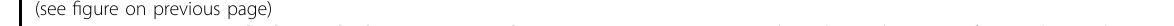
Fig. 1 p97 expression is higher in the breast CSC population. a Representative immunohistochemical staining of p97 in human breast, colon, liver, and pancreatic cancers and adjacent noncancerous tissues. Bar: 20 μ m. b Representative immunohistochemical staining of high-level p97 (red) co-stained with CD44 (brown, left) and CD24 (brown, right) in two consecutive serial sections of human breast cancer tissues. c Representative immunohistochemical staining of low-level p97 (red) co-stained with CD44 (brown, left) and CD24 (brown, right) in two consecutive serial sections of human breast cancer tissues. Bar: upper 200 μ m, lower 50 μ m. Note that p97 primarily localized to CD44 + /CD24 − cells but not other cells. d Percentages of p97 expression in CD44 + /CD24 − cells and non-CD44 + /CD24 − (CD44 − /CD24 − , CD44 − /CD24 + , and CD44 + /CD24 + ) cells in breast cancer tissues ( n = 75). e Immunohistochemical staining of SOX2 and p97 in the consecutive serial sections of breast cancer tissues. SOX2 and p97 expressions were classi fi ed as low and high. Bar: upper 200 μ m, lower 50 μ m. f Correlation analyses of SOX2 and p97 expression in breast cancer tissues ( n = 75). g Immunoblotting of p97 in lysates of MCF10A, MCF-7, and MDA-MB-231 cells. GAPDH was used as a loading control. h Left: fl ow cytometry analysis of CD44 and CD24 in MCF10A, MCF-7, and MDA-MB-231 cells. Right: the CD44 + /CD24 − percentages. i qPCR analysis of P97 mRNA in CD44 + /CD24 − , non-CD44 + /CD24 − , ALDH + , ALDH − , PKH26 + , and PKH26 − populations. j , k Immunoblotting analysis of p97, OCT4, and SOX2 in CD44 + /CD24 − , CD44 − /CD24 − , ALDH + , and ALDH − populations isolated from MCF-7 and MDA-MB-231 cells. GAPDH was used as a loading control. Data were shown as mean + SD. * P < 0.05 and *** P < 0.001.